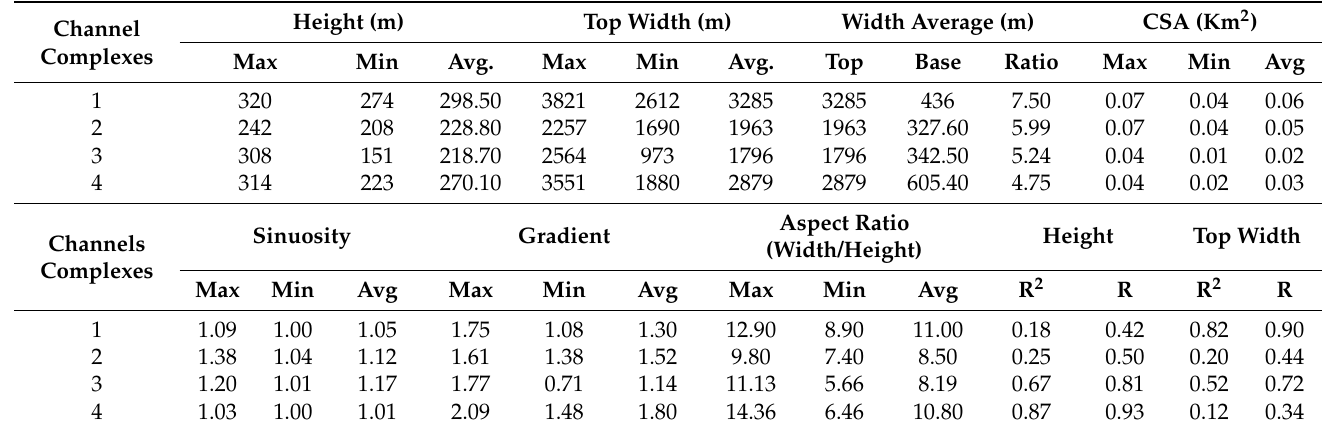
Table 1. Average morphometry data of four channel complexes in the study